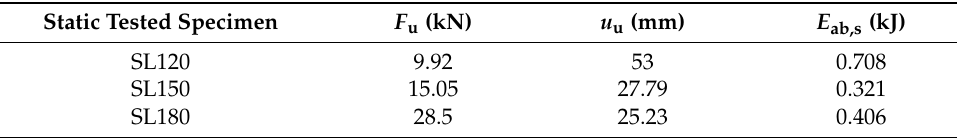
Table 3. Results of static